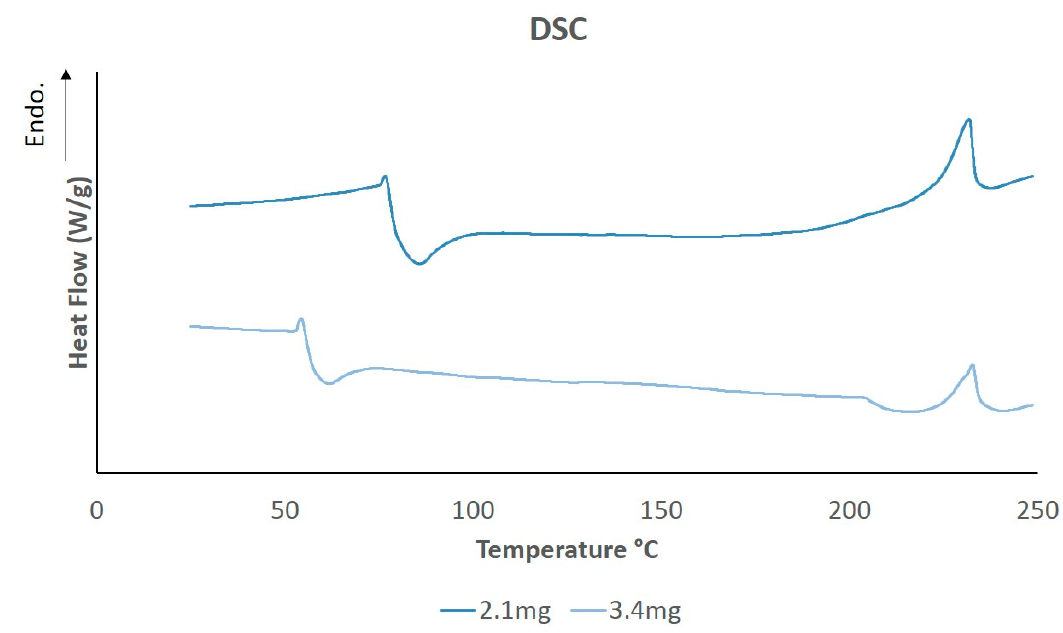
Figure 8. Differential scanning calorimetry (DSC) thermal diagram of PVA samples at different weights. Table 2. DSC results for melting temperature and crystallinity. Measurements were made on a Q10 TA Instruments. Samples were heated at a rate of 5 ◦ C/min from 25–250 ◦ C in a nitrogen atmosphere. Sample Weight